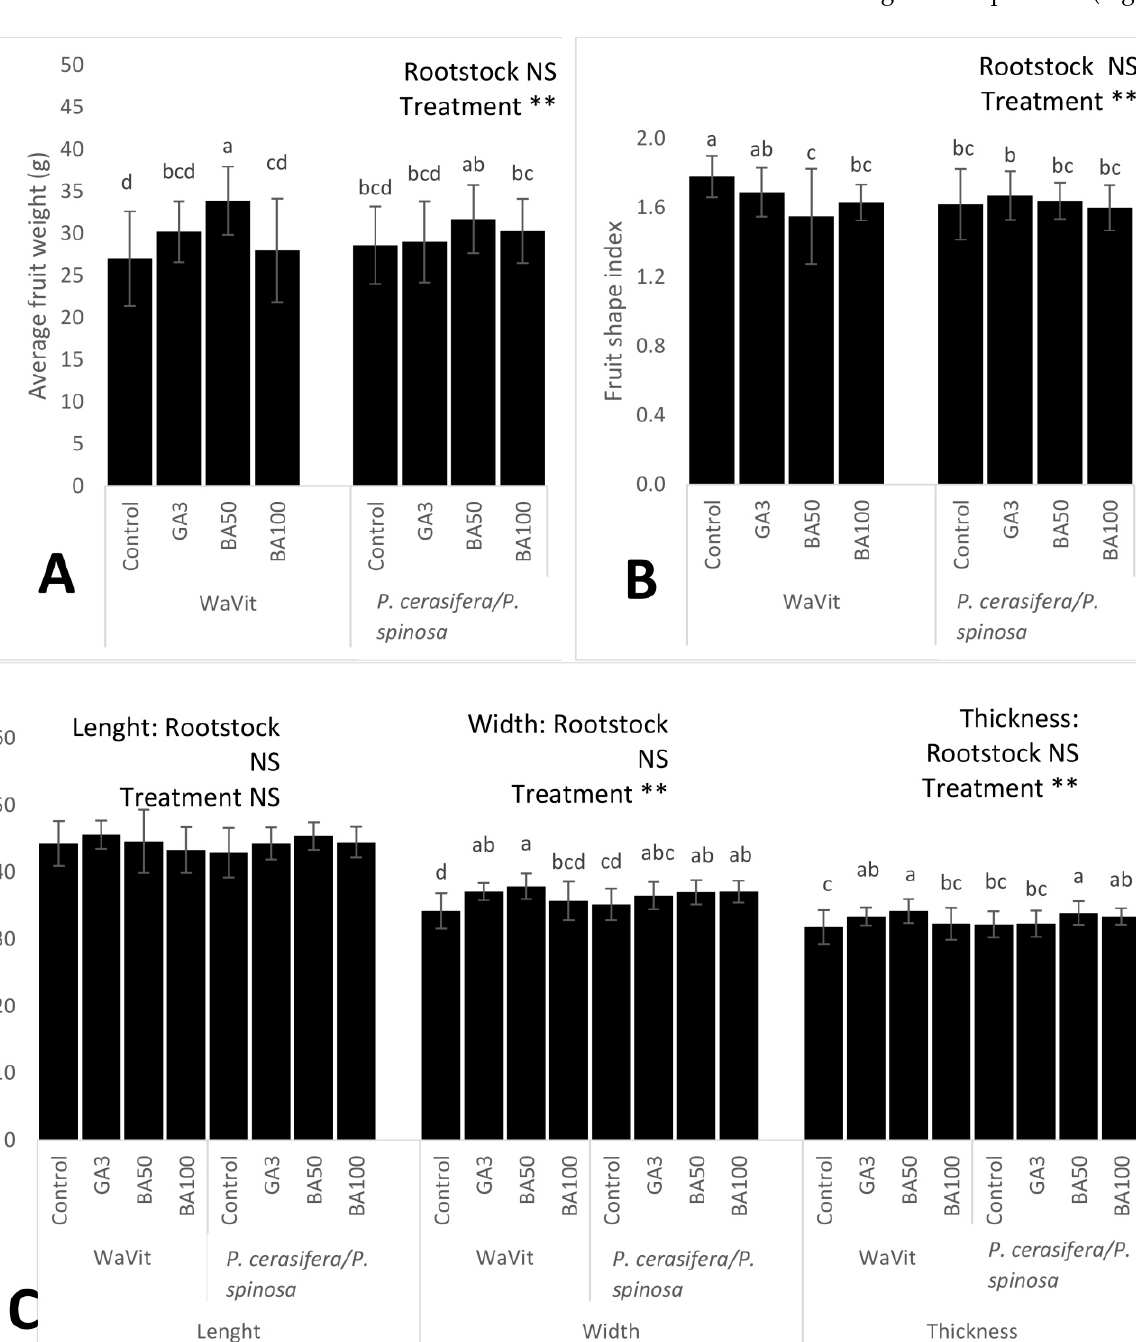
Figure 1. Changes in weight and size of fresh plum, grown on two different rootstocks (“WaVit” and P. cerasifera / P. spinosa ), treated with PGRs. ( A ) Fruit weight (g); ( B ) fruit shape index; ( C ) fruit size (length, width and thickness, mm). PGR treatment: control—untreated plums; GA 3 —200 mg L − 1 of gibberellin A3; BA50—50 mg L − 1 of 6-benzyladenine; BA100—100 mg L − 1 of 6-benzyladenine. Marks in one graph followed by the same letter were not significantly different ( p < 0.05). The main factors are presented, and their significance is annotated by: NS—not significant, **—significant at 0.01. The error bars on the columns represent the standard